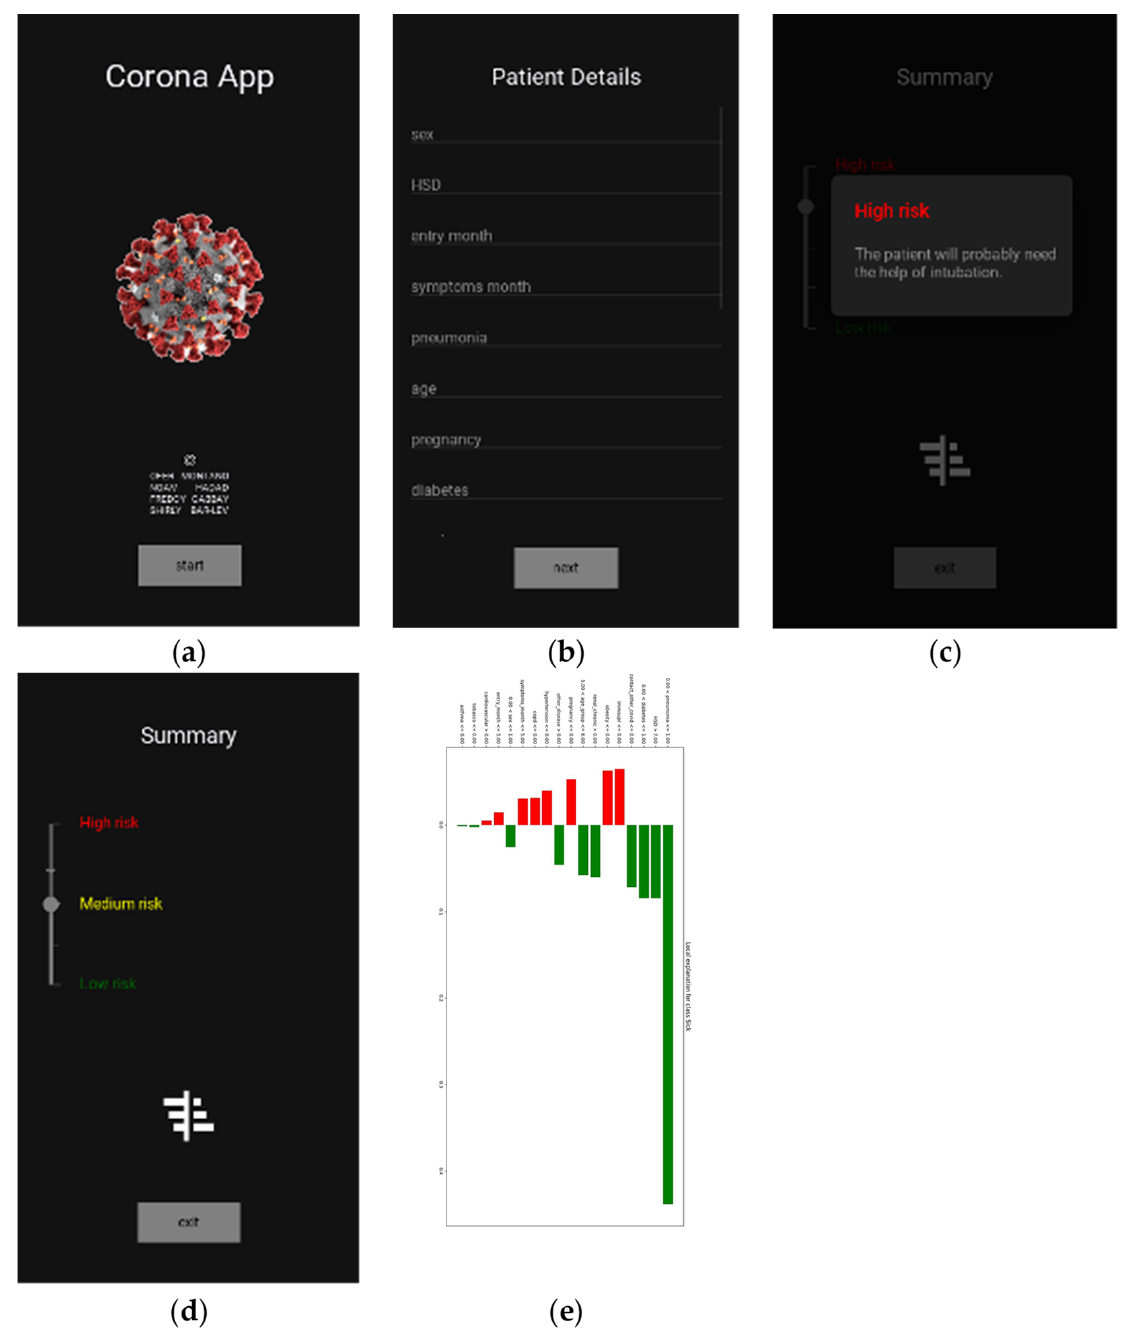
Figure 5. COVID-19 application user-interface (UI): ( a ) home page, ( b ) patient details form, ( c , d ) prediction of a patient’s severity of illness for models A and B, respectively, and ( e ) an explanation of the prediction.